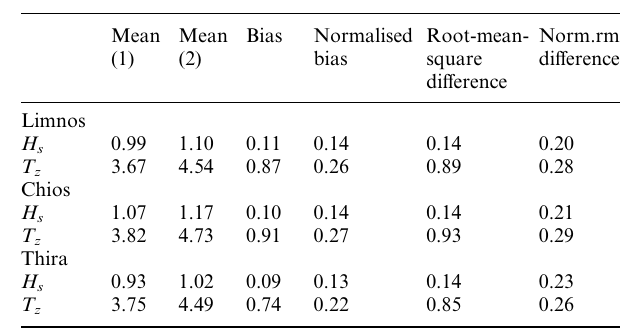
Table 16. Statistics for the storm December 1991, –128 points. Comparison of results from WAM model (cy3–cy4)using UKMO